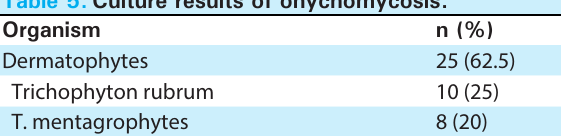
Table 5. Culture results of